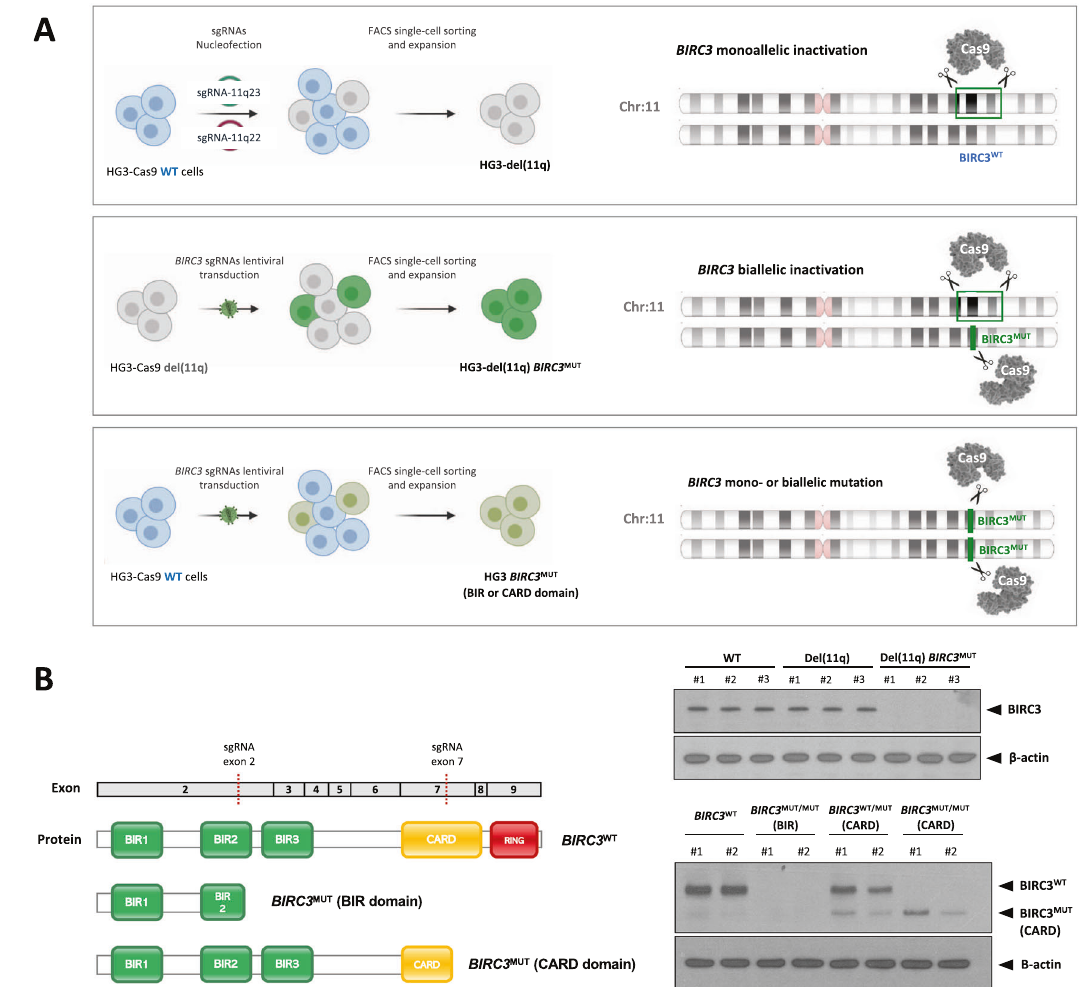
Fig. 1 Generation of isogenic CRISPR/Cas9-edited CLL cell lines harboring del(11q) and/or BIRC3 mutations. A Experimental design for the CRISPR/Cas9-mediated generation of BIRC3 -related alterations in the Cas9-expressing HG3 CLL-derived cell line. Upper panel represents